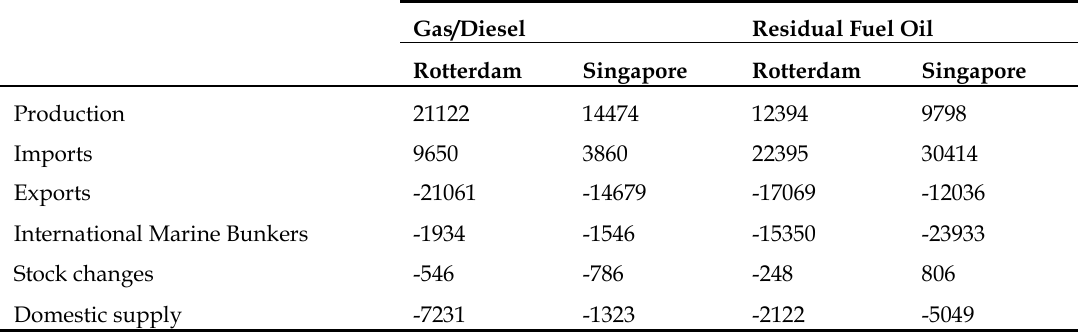
Table 2. Oil statistics 2005 of the ports of Rotterdam and Singapore in ktons per